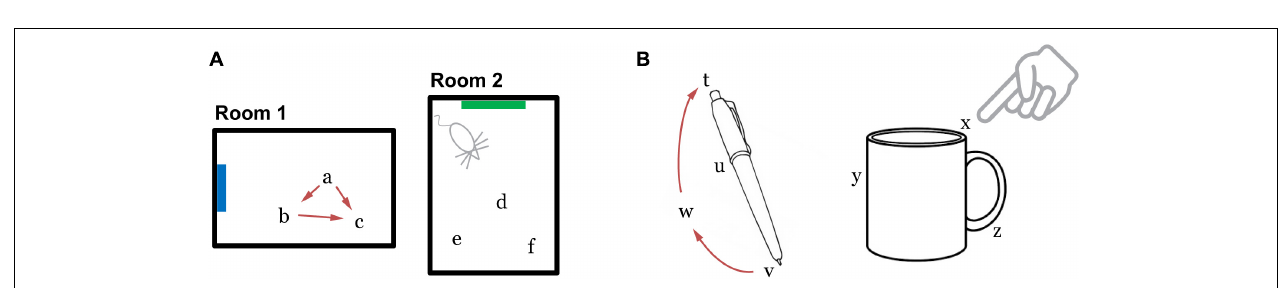
FIGURE 1 | Grid cells represent locations in environments. (A) An individual grid cell becomes active at multiple locations (green circles) in an environment. The locations of activation form a repeating grid-like lattice. (B) A grid cell module (left) is a set of cells that share the same lattice scale and orientation but which activate at different relative positions in the environment. If you sort the cells by their relative firing locations, it forms a rhombus-shaped tile. As the animal moves, as shown by the arrow, a bump of cell activity will move in some direction through this rhombus. Two grid cells and their firing locations (green and blue) are highlighted. The grid cell module will activate cells at every location in an environment, but because of tiling, a single grid cell module cannot represent a location uniquely. (C) This figure shows how a second module tiles the same space differently. Each cell’s firing lattice has a larger scale and a different orientation than the module in (A,B) . The same movement of the animal as shown by the arrow causes the bump to move in a different direction and a different distance than the bump in the first module in (B) . In this case, the bump overlaps the edge of the rhombus, so it wraps around. (D) Although a single module cannot represent locations in an environment uniquely, the activity across multiple modules can. Here, we superimpose the firing patterns of the two modules. Note that when the green and red cells fire together, only one location is possible. The larger the number of modules, the more locations that can be represented uniquely.